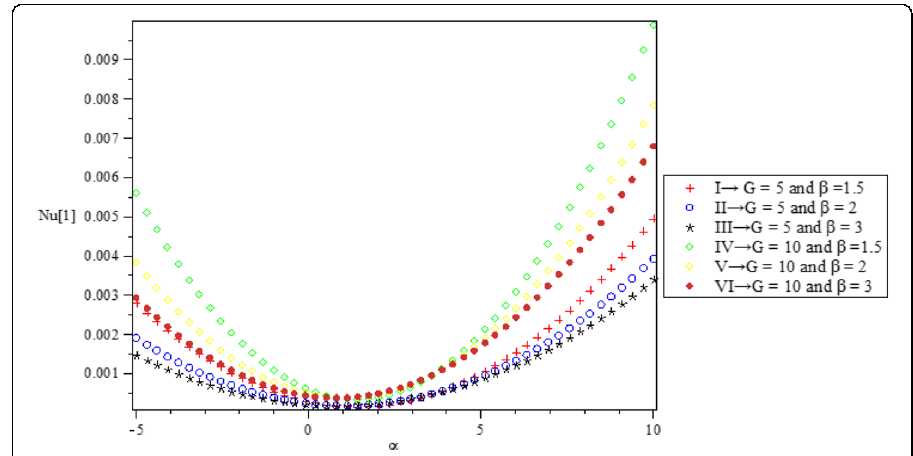
Fig. 33 First-order Nusselt number (Nu[1] profile, r = − 1, ϵ = 0.25, P = 0.71, λ = 0.01, and y =